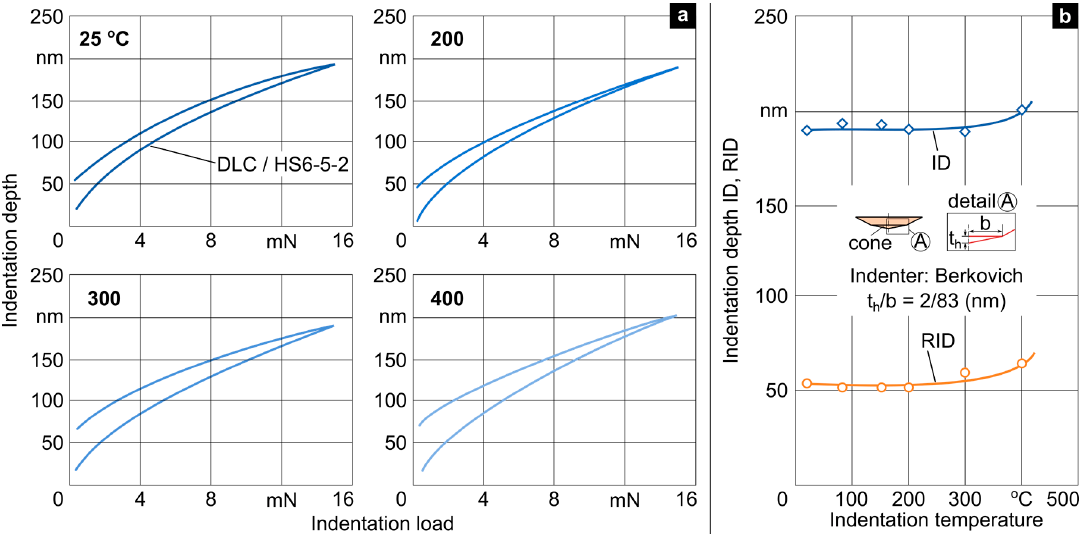
Figure 9. ( a ) Nanoindentation results on the applied DLC coating at various temperatures; ( b ) obtained maximum depths (IDs) and RIDs of the DLC coating versus the temperature.